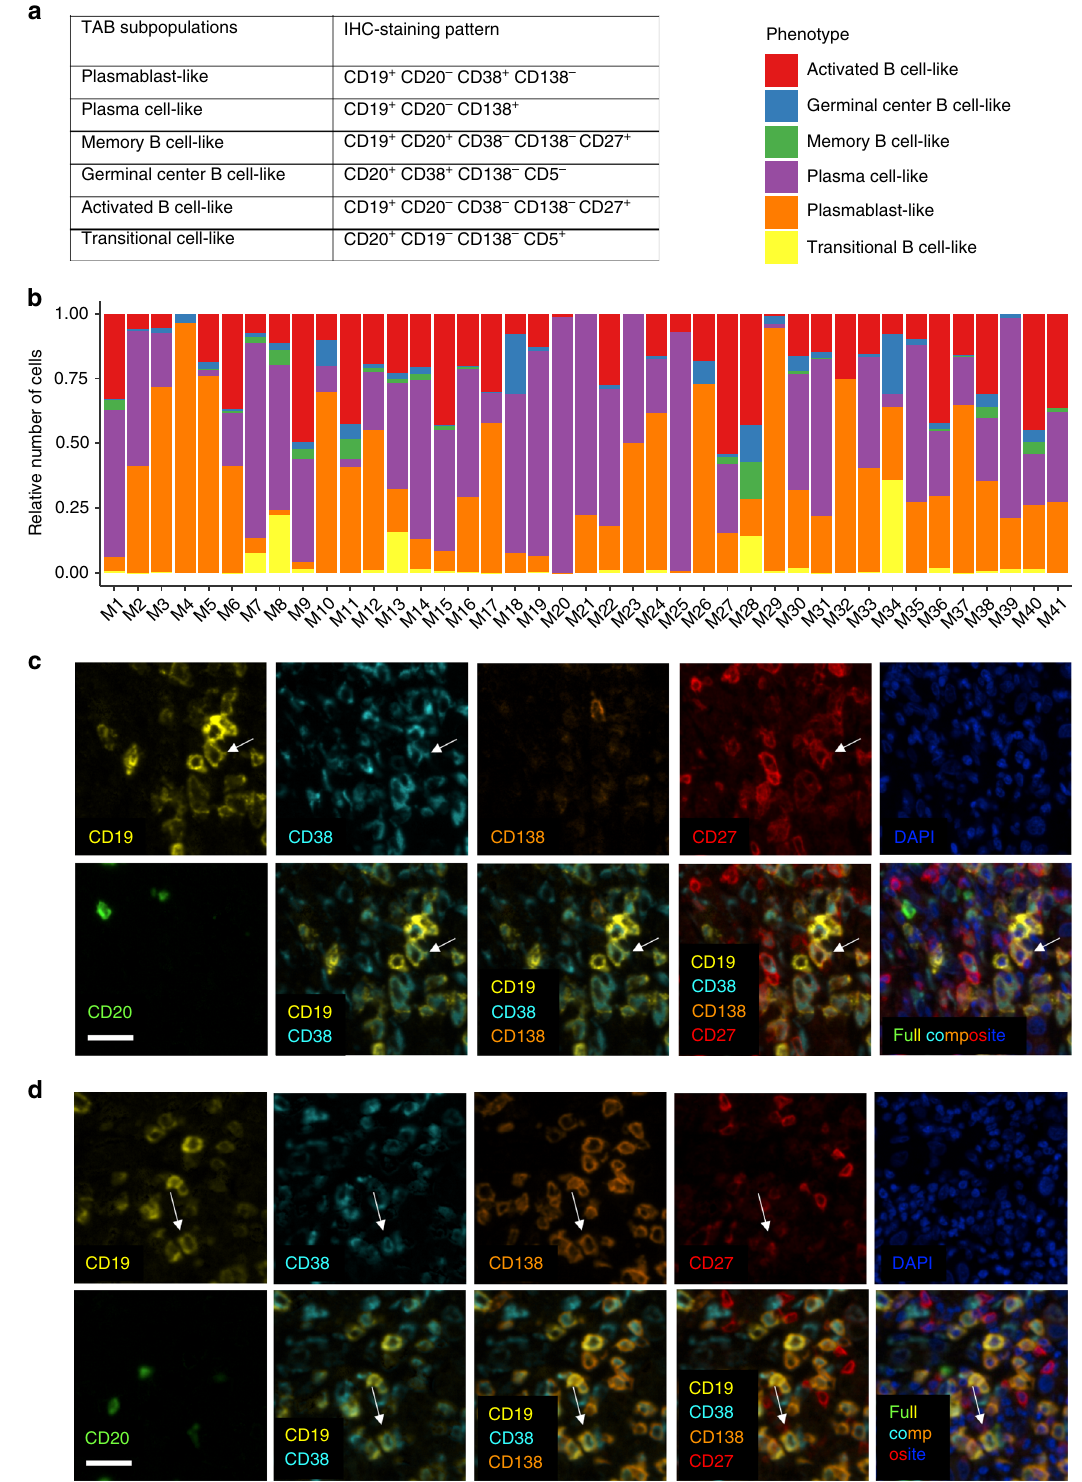
Fig. 1 Melanoma TAB are enriched for plasmablast- and plasma cell-like phenotypes. a Marker combinations used to identify TAB subpopulations by seven-color multiplex immunostaining. b Relative frequency of different TAB phenotypes in whole tissue sections of 41 metastatic melanomas c , d Multiplex immunostaining identi fi es CD19 + CD20 − CD38 + CD138 − CD27 + plasmablast-like ( c ) TAB and CD19 + CD20 − CD38 + CD138 + CD27 + plasma cell-like ( d ) TAB. Here, serial images display the same cells from a stromal area at the invasive tumor margin. A full composite image together with DAPI nuclear staining (bottom right) and images for each of the individual markers and different combinations from the composite image are shown. Arrow depicts one of several plasmablast-like ( c ) and plasma cell-like ( d ) TAB. Scale bars represent 20 µ